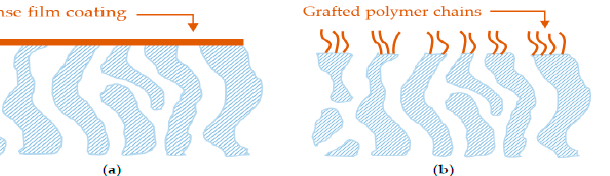
Figure 27. Diagram of membrane surface alteration to improve antifouling characteristics. Coating of a thin nonporous dense layer ( a ) and grafting of polymer chains on top of membranes ( b ) [288].